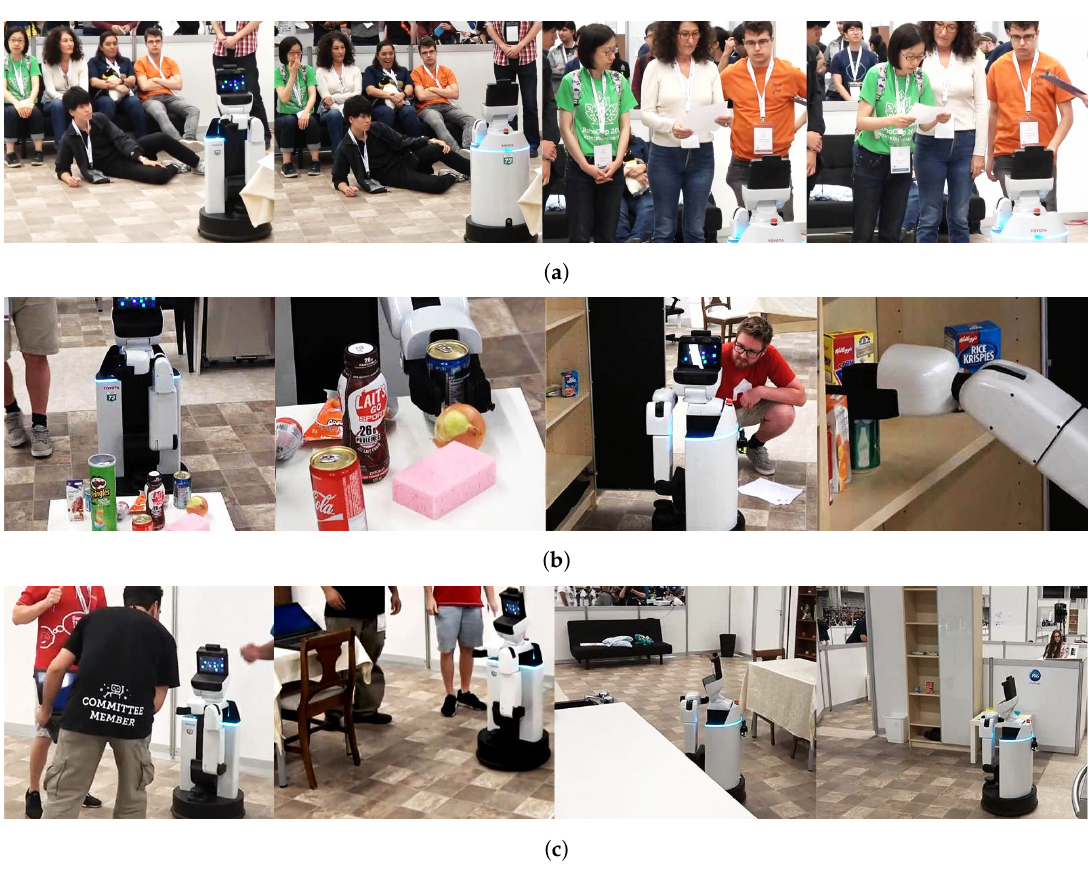
Figure 13. The HSR doing various tasks at the RoboCup@Home 2018 Competition. ( a ) Speech and Person Recognition Task, ( b ) Grocery Task and ( c ) General Purpose Service Robot